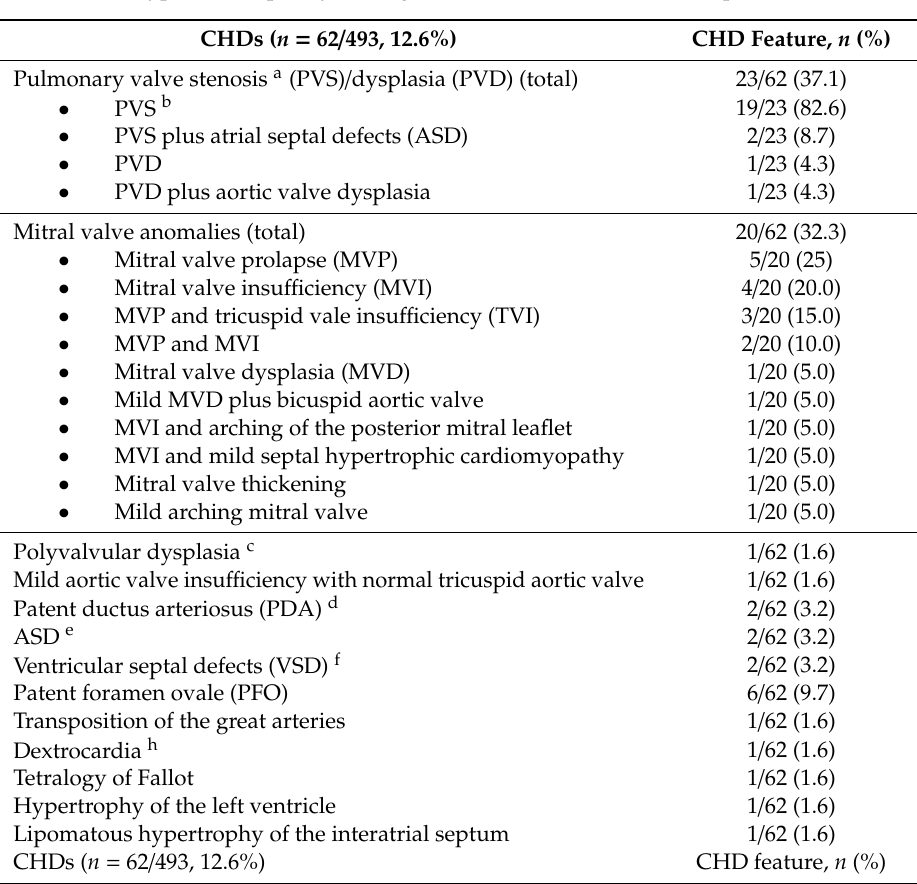
Table 1. Type and frequency of congenital heart diseases (CHDs) in present